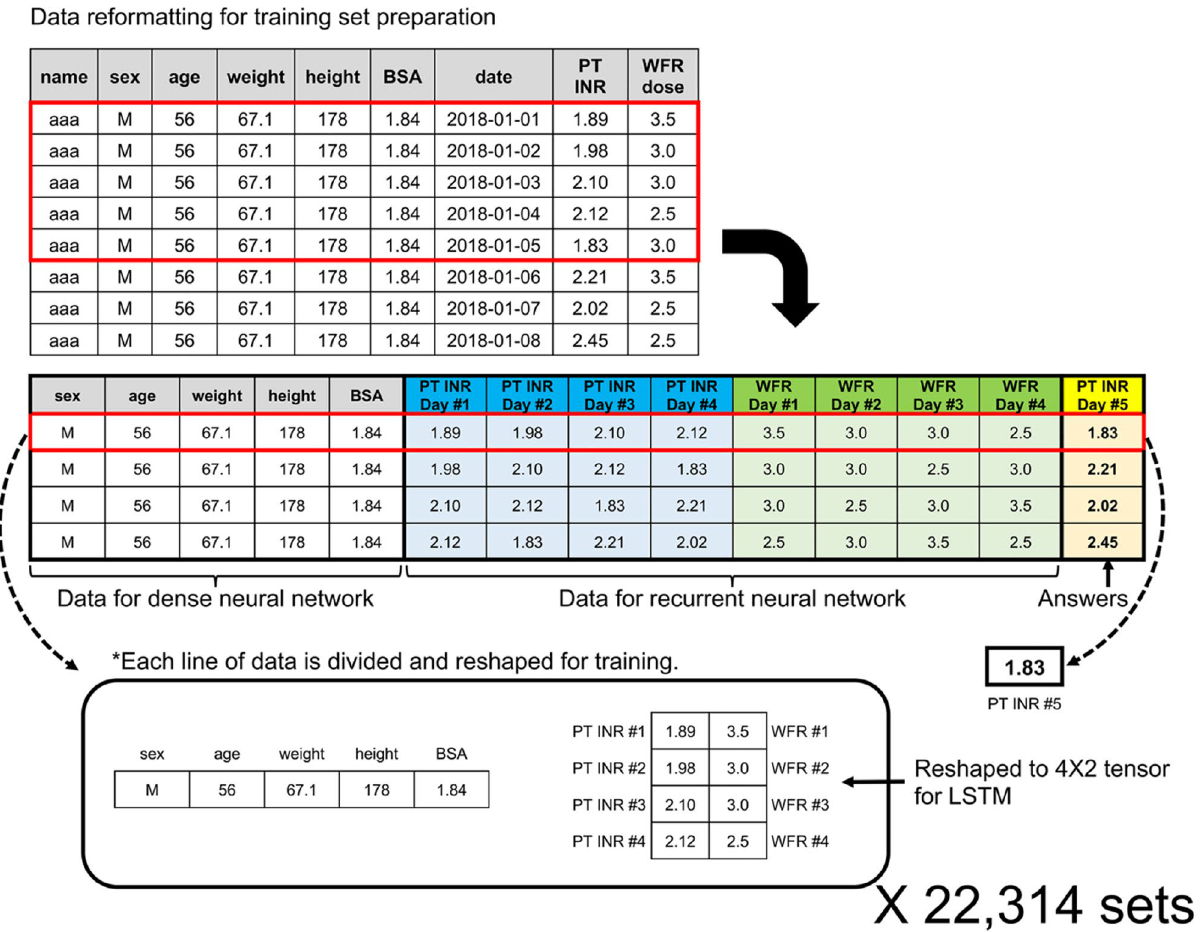
Figure 3. Datasets prepared for the dense and recurrent neural networks (RNN). Raw data were reformatted into data for the dense neural network, recurrent neural network, and correct answers. The standardization process is not shown here to avoid complexity. BSA body surface area, PT INR prothrombin time international normalized ratio, WFR warfarin, LSTM long short-term